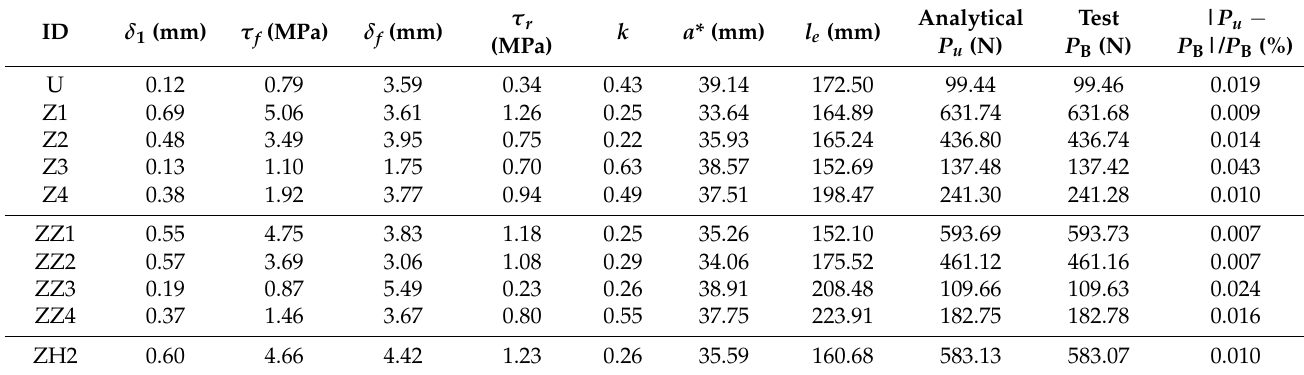
Table 2. Calibrated interfacial